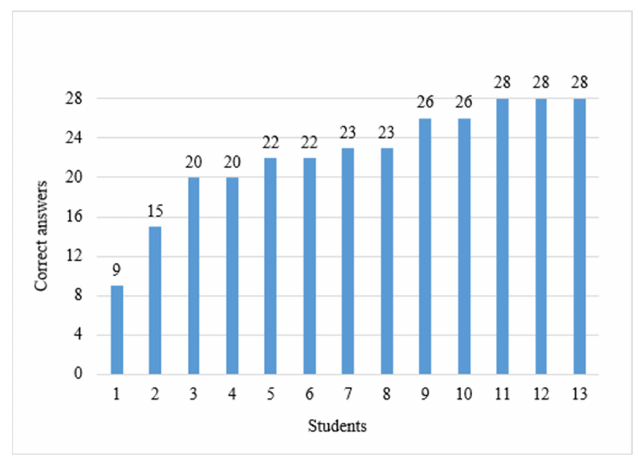
Figure 11. Third grade students’ performance (correct answers) in the post-test.